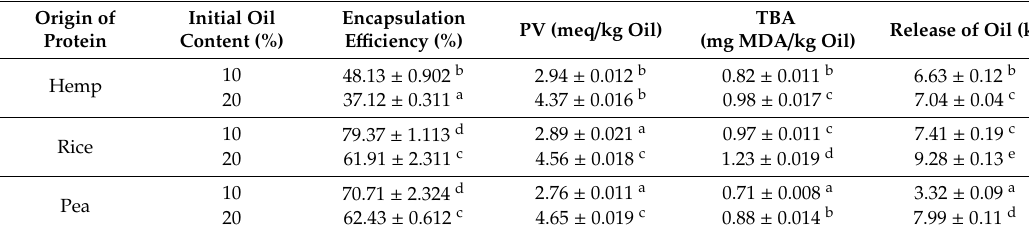
Table 3. Encapsulation e ffi ciency, oxidation, and oil release from hempseed oil microcapsules encapsulated with combination of proteins with